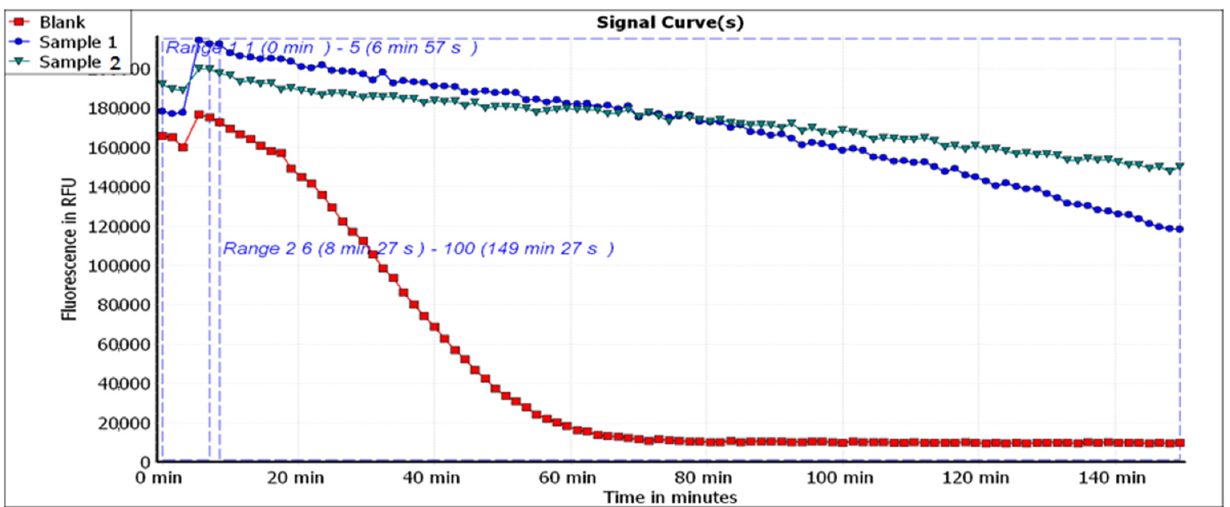
Figure 4. Signal curves indicating the decay of fluorescein upon applying the extracts: (1) Pleurotus ostreatus and (2) Lentinula edodes.